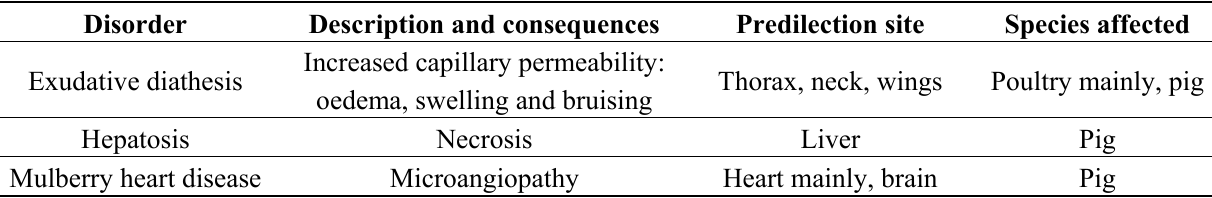
Table 4. Summary of specific clinical disorders that respond to selenium supplementation (adapted from Suttle